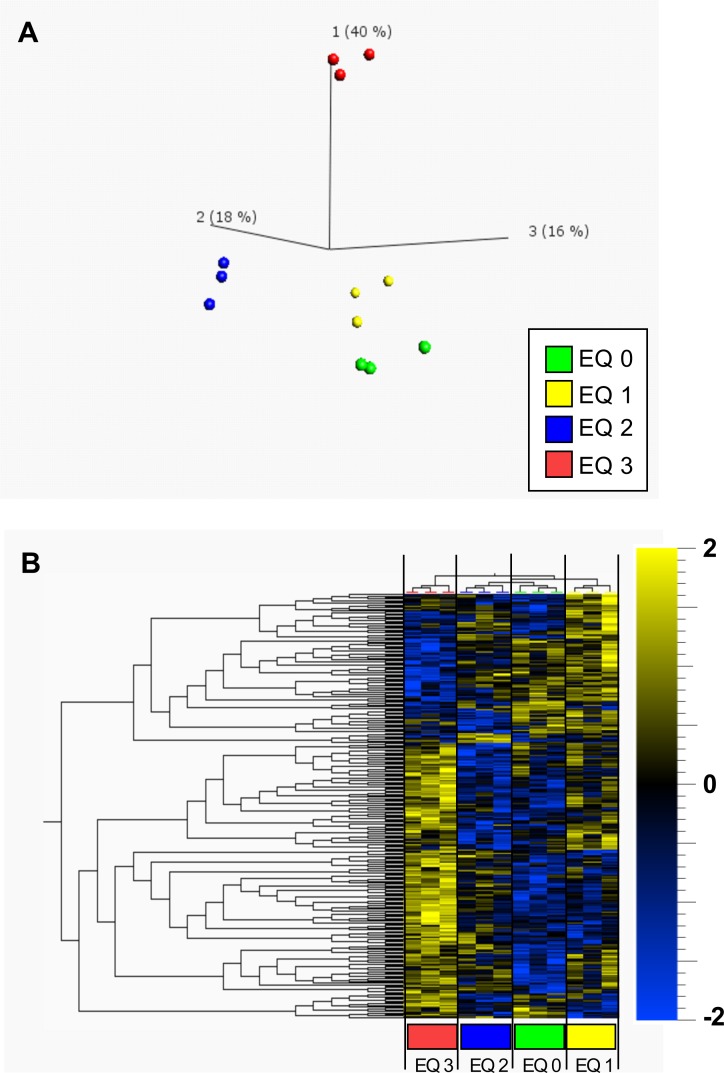
Principal component analysis (PCA) and hierarchical clustering (HC) of 287 significantly regulated (p<0.05, ANOVA) proteins in livers of Atlantic salmon (Salmo salar L.) exposed to graded levels of ethoxyquin (EQ) through their diet for 90 days.Differential analysis (ANOVA), PCA (A) and HC (B) were performed using the Qlucore omics-explorer. The heatmap (B) represents the concentrations of significantly regulated proteins within each measured sample (represented in the columns). Yellow bars indicate higher concentrations of a protein, while blue bars indicate lower concentrations of a protein, on a scale from -2 to 2, where 1 unit is equal to a variance of 1 from the mean. See S9 Table for a complete overview of individual proteins.